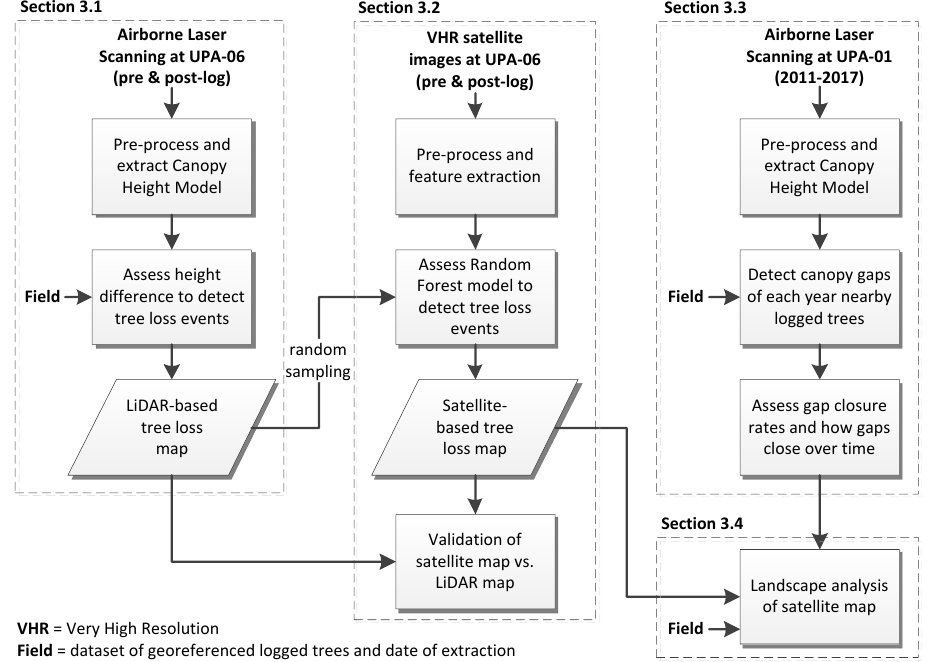
Figure 2. Main steps of the data processing and